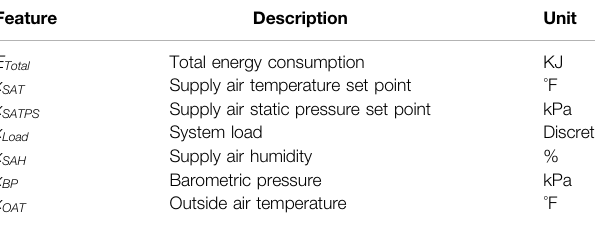
TABLE 1 | Introduction of the related features collected in the